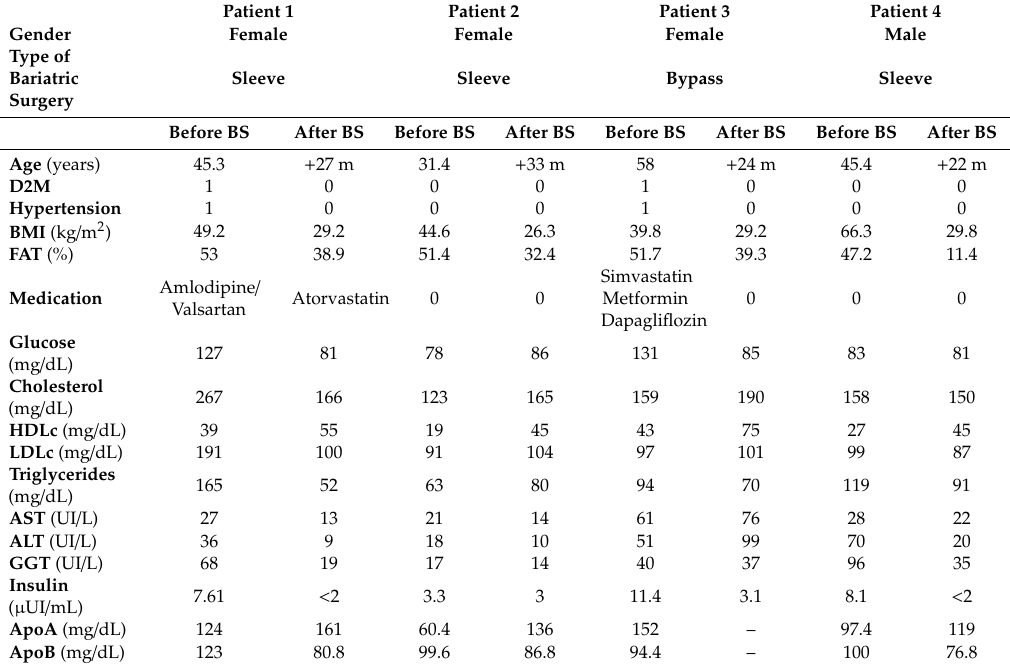
Table 1. Anthropometric and biochemical parameters of patients used for mass spectrometric